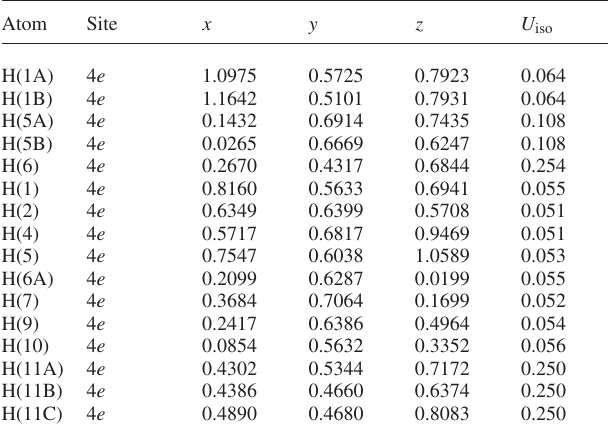
Table 2. Atomic coordinates and displacement parameters (in Å 2 )